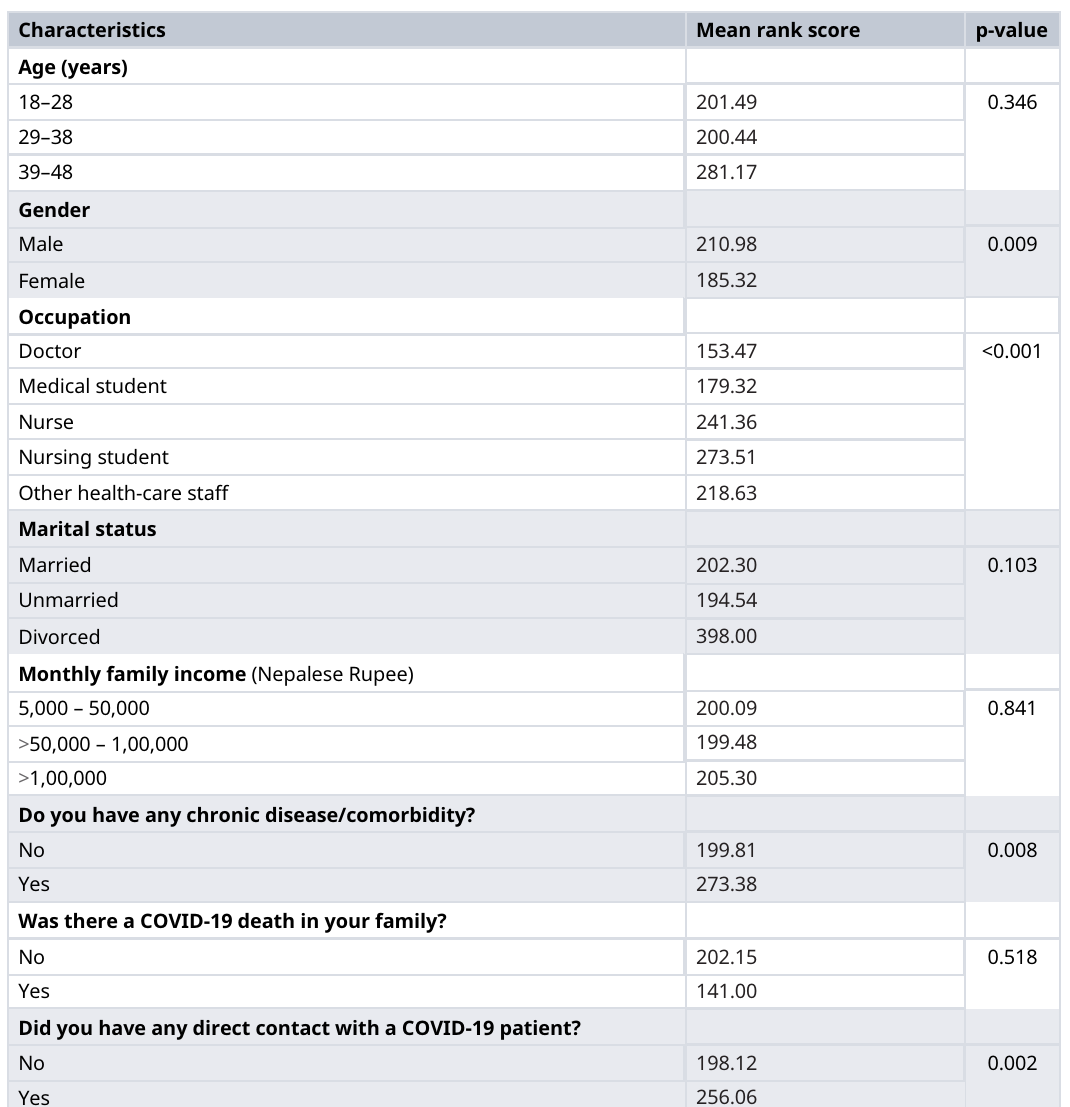
Table 4. Anxiety scale scores stratified by respondents ’